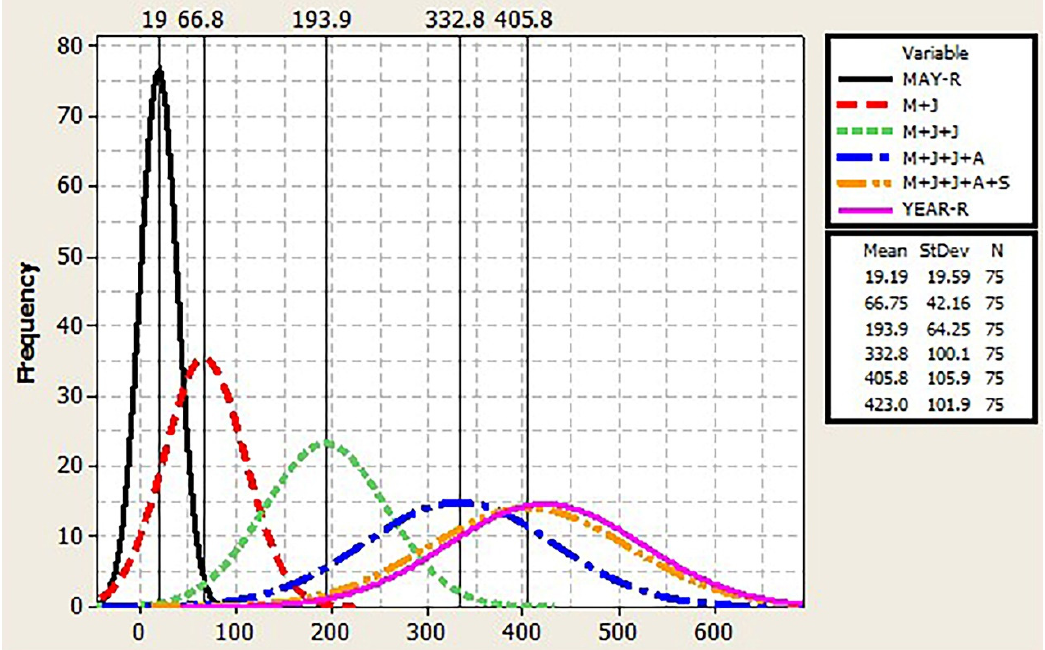
Figure 4. Seasonal monthly accumulated precipitations frequency histogram.